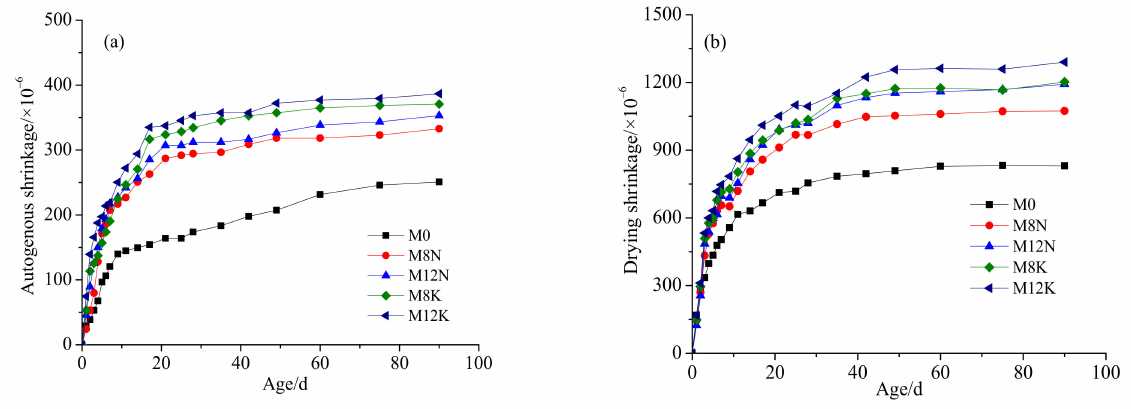
Figure 3. Shrinkage of MHPC mortars with different alkali sulfates contents. ( a ) Autogenous shrinkage; ( b ) drying